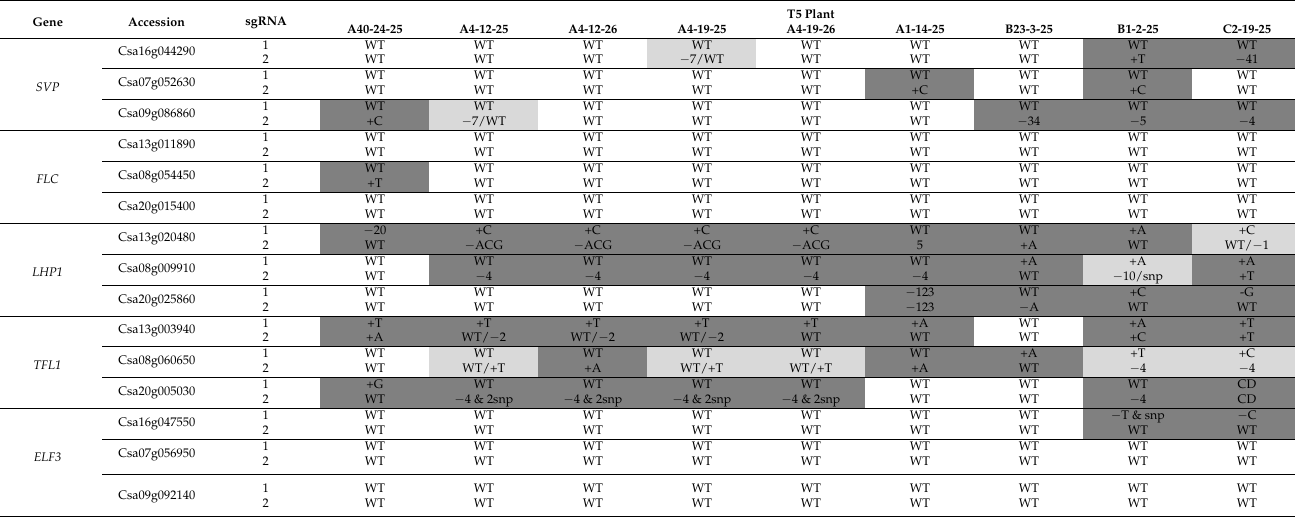
Table 2. Summary of genotypes of the T5 individual